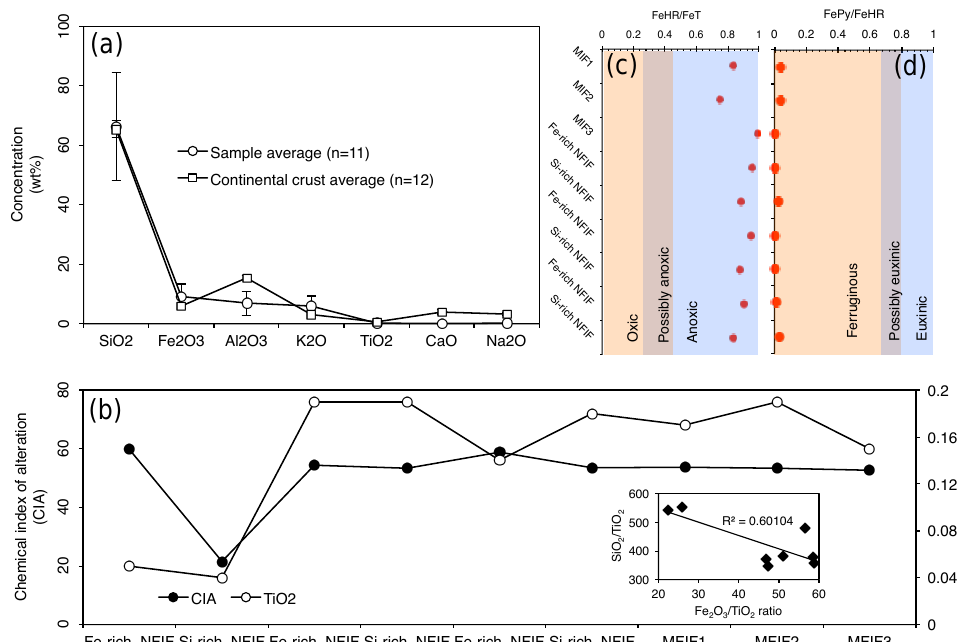
Figure 13. Bulk average concentrations of major trace elements, chemical weathering indices, and reconstructed redox depositional condi- tions for typical MFIF and the Fe- or Si-rich NFIF bands for the sawn rock sample in Fig. 7e. (a) Relationship between average major trace element content and average continental crust (Rudnick and Gao, 2003). (b) CIA. Inset, relationship between SiO 2 and Fe 2 O 3 . (c) Highly reactive Fe (FeHR) to total Fe ratio (FeT). (d) Pyrite to FeHR ratio.